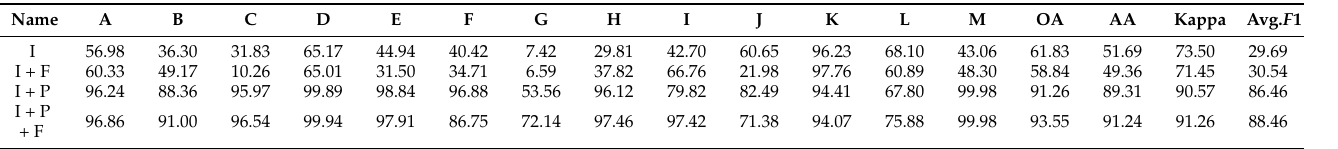
Table 2. Overall classification results and per category results for Area_1. (I: image, F: building footprint, P: points of interest).